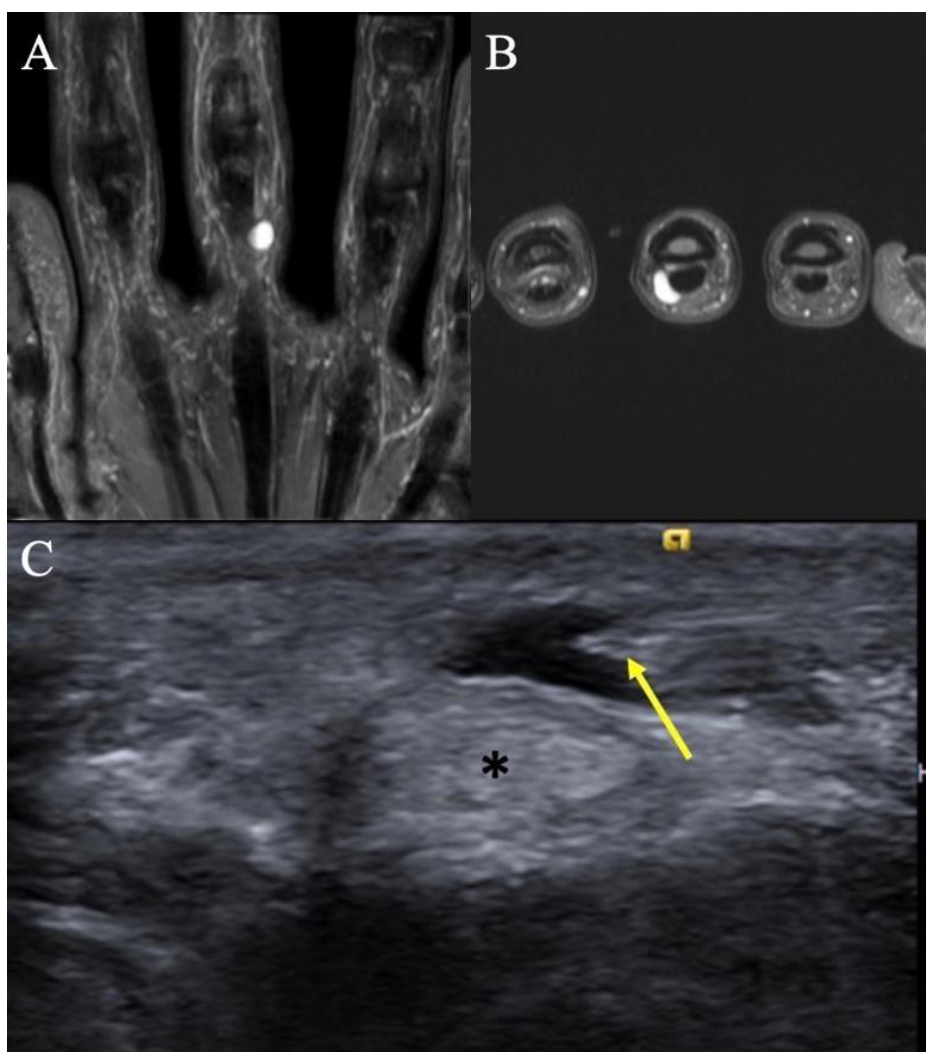
Figure 2. Retinacular cyst. ( A ) Coronal T2-weighted image of the hand showing a homogenous, hyperintense mass on the ulnar aspect of the long finger with no internal septations. ( B ) Axial T2- weighted image re-demonstrating the homogenous, hyperintense lesion abutting the flexor tendon. ( C ) Transverse ultrasound at the palmar aspect of the small finger MCP joint in a different patient demonstrates a medial approach for an ultrasound-guided percutaneous needle decompression (arrow) of an A1 pulley retinacular cyst; note safe distance of the needle tip from the flexor tendon (*).